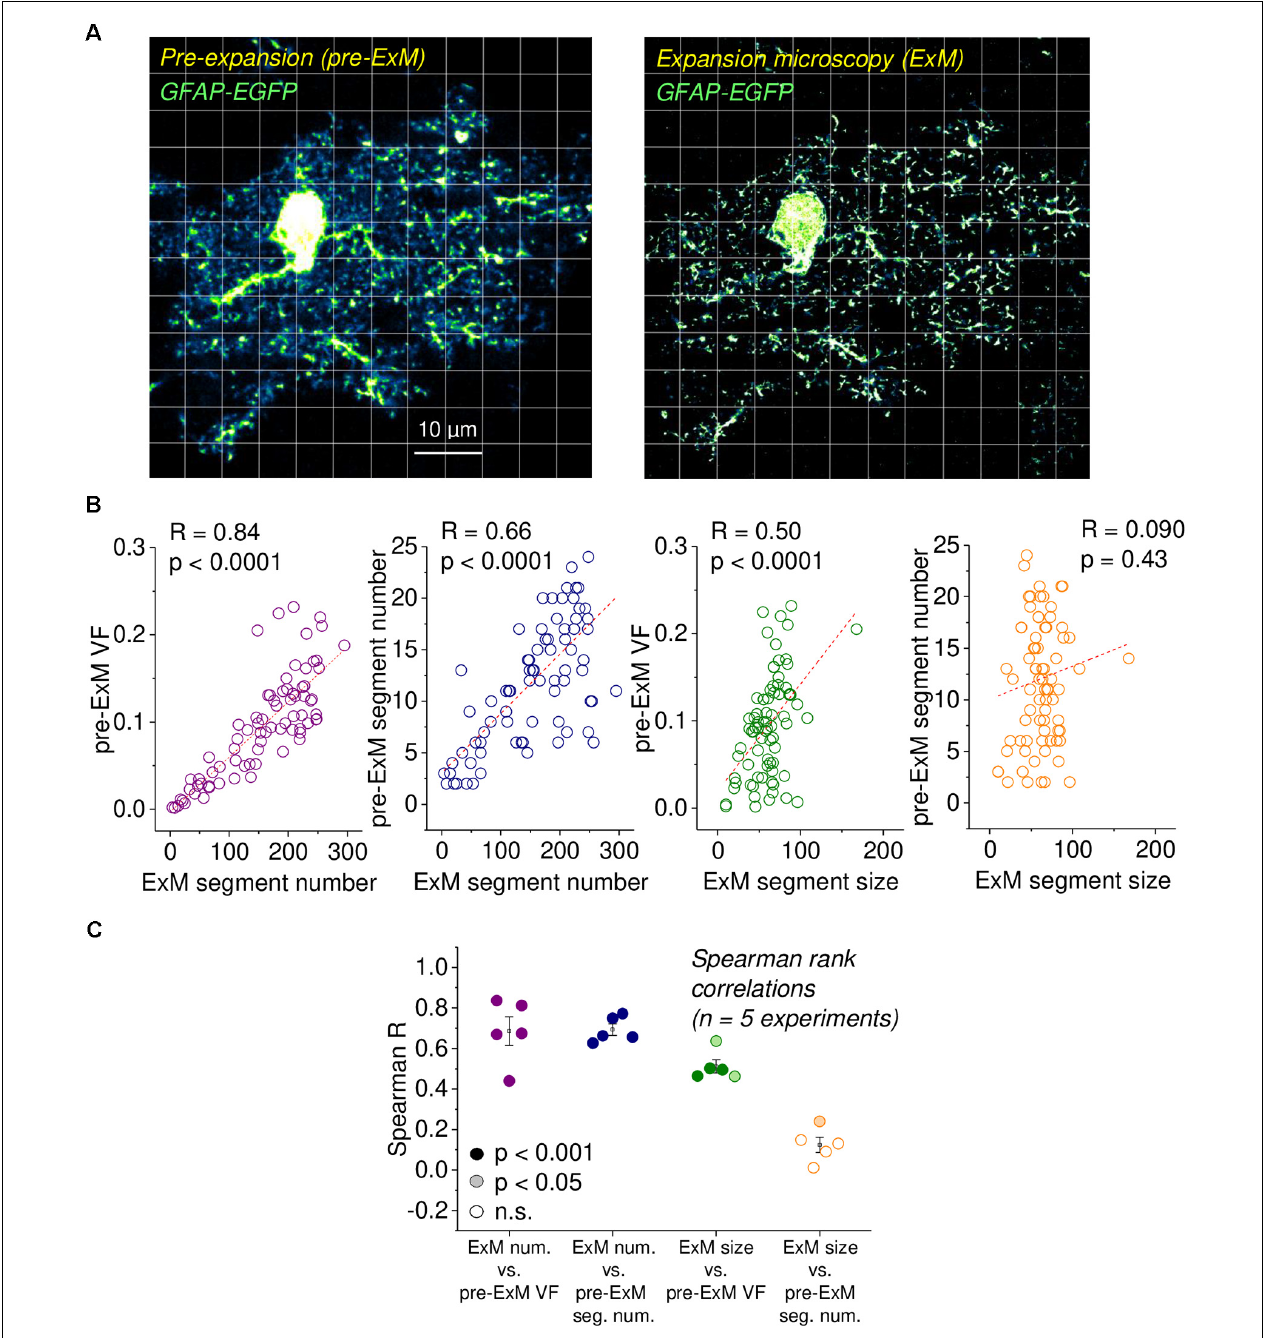
FIGURE 2 | Validation of astrocytic volume fraction (VF) and segment density using expansion microscopy (ExM). (A) Example of an EGFP-expressing astrocyte before expansion (left panel, pre-ExM) and after expansion (right panel, ExM), both obtained using confocal microscopy. The ExM image was rescaled to the original size of the tissue. The scale bar applies to both panels and refers to the pre-ExM dimension. Note the highly resolved small astrocyte processes and the disappearance of out-of-focus structures in ExM. The grid illustrates the regions of interest (ROIs) for both images. The soma and areas without astrocyte structures were excluded from the analysis. Experimental data from Herde et al. (2020). (B) For each ROI in (A) , the VF and segment number were determined from the pre-ExM image and compared with the average segment size and number of segments measured in the ExM image in the same ROI. Strong correlations were found between the astrocyte segment number after expansion with the pre-expansion VF and segment number (1st and 2nd panel from the left) and between the astrocytic segment size after ExM and the pre-expansion VF (3rd panel from the left) but not between the astrocytic segment size after ExM and the pre-expansion segment number. Spearman rank correlations throughout ( n = 77 ROIs). Dashed lines are linear fits, only for illustration. (C) Spearman’s rank correlation coefficients for five independent experiments, as illustrated in (A,B) . Filling represents statistical significance (dark for p < 0.001, light for p < 0.05 and white for p > 0.20).